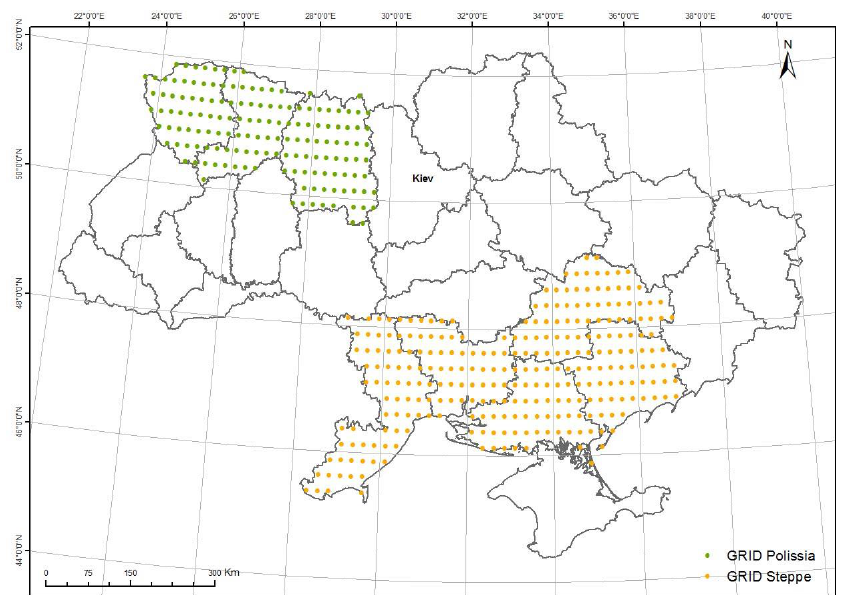
Figure 2. The grid of satellite measurements of methane atmospheric concentration over physiographic regions of